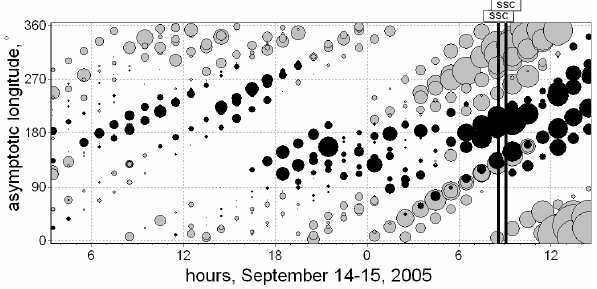
Figure 4: Forbush effect on September 15, 2005: distribution of the CR variations by Fig. 4. Forbush effect on 15 September 2005: distribution of the CR asymptotic longitudes after reduction of the isotropic part. Black circles signify a decrease of intensity and gray circles an increase relatively to the base value before the FE. The size of variations by asymptotic longitudes after reduction of the isotropic the circle is proportional to the amplitude of CR variation. Vertical lines indicate the timing of part. The black circles signify a decrease of intensity and the gray the shocks (8:35UT and 9:04UT) circles an increase relatively to the base value before the FE. The size of the circle is proportional to the amplitude of CR varia- tion. Vertical lines indicate the timing of the shocks (08:35UT and 09:04UT).